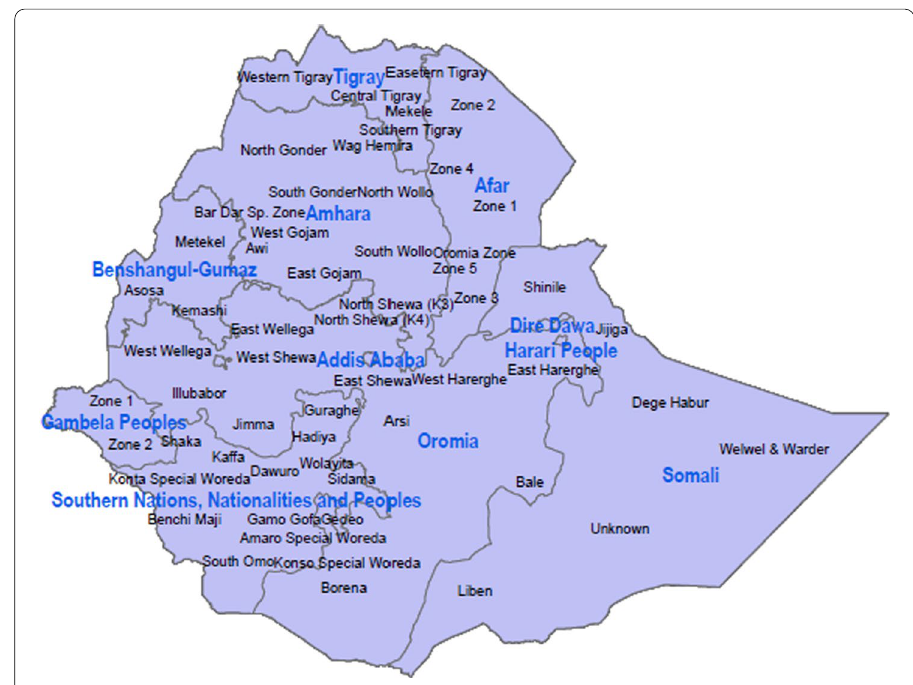
Fig. 1 Map of Ethiopia with administrative regions and zones